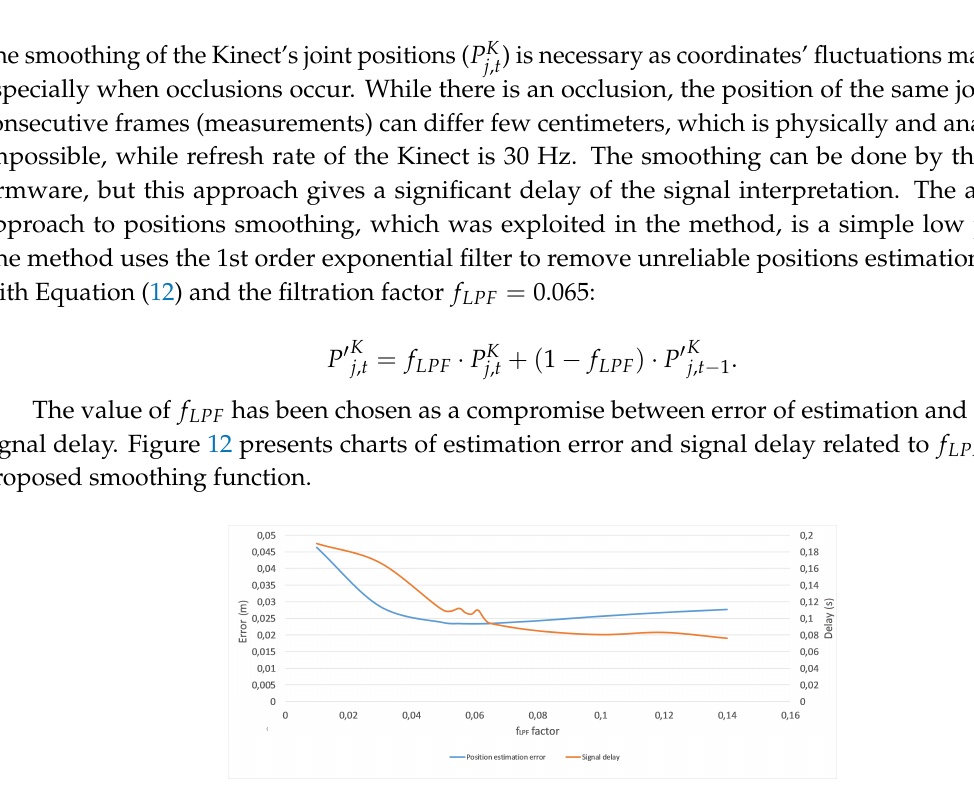
Figure 12. Estimation error and signal delay of smoothing function